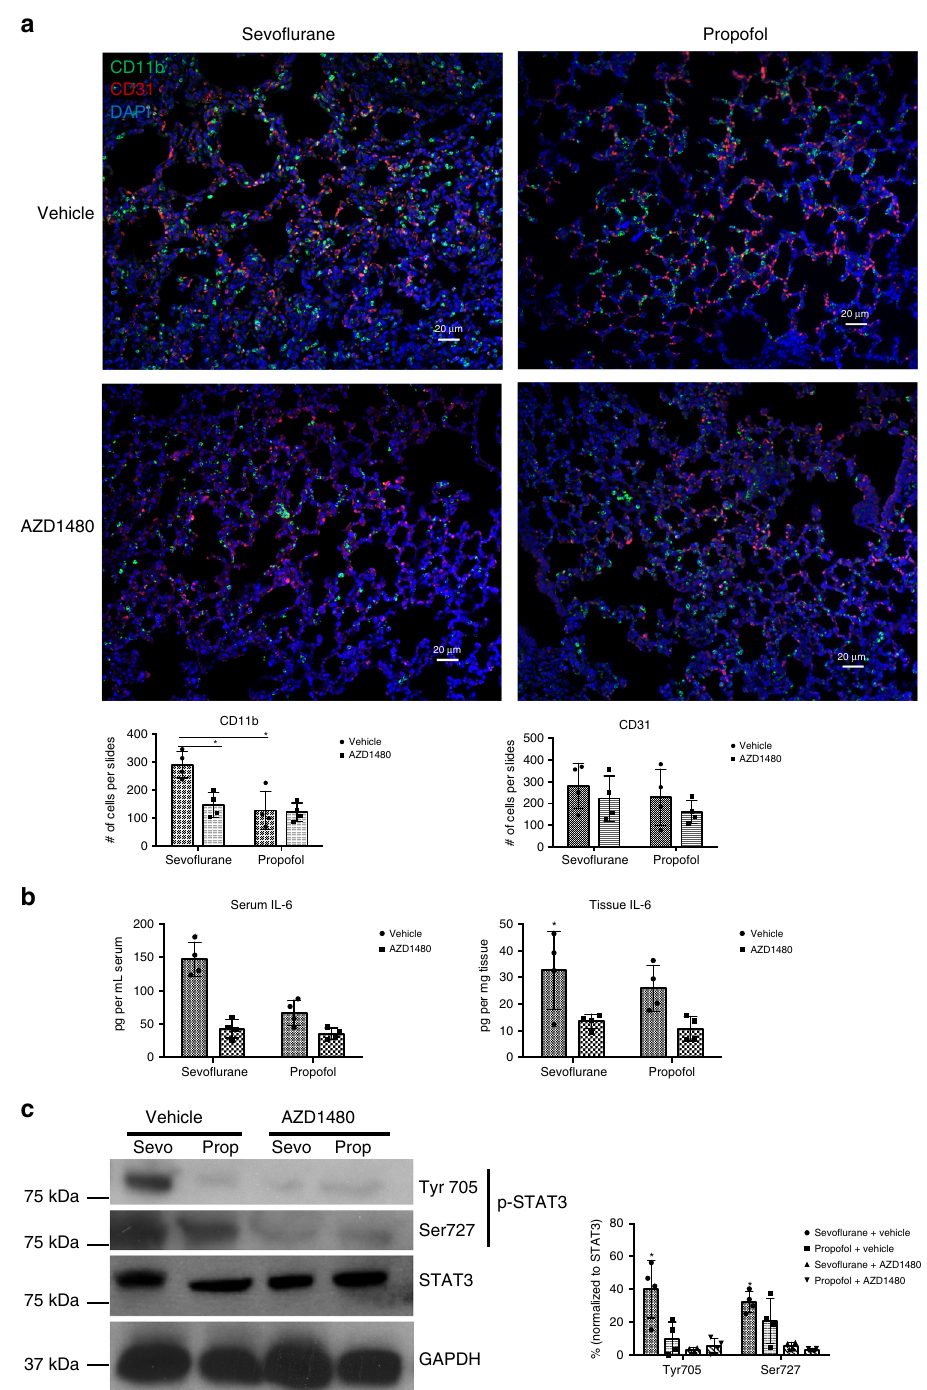
Fig. 4 AZD1480 treatment reduced the in fi ltration of CD11b + myeloid cells associated with sevo fl urane in the lung. a Sevo fl urane increased CD11b + cells in the lung one day after surgery compared to propofol by immuno fl uorescence imaging. Treatment with AZD1480 signi fi cantly reduced in fi ltrated CD11b + cells (green) induced by sevo fl urane in the lungs ( n = 4 mice in each group; sevo fl urane vs propofol, p = 0.007; sevo fl urane vehicle vs AZD1480, p = 0.032; two-way ANOVA + Dunnett ’ s post hoc tests, Scale bar = 20 μ m). No signi fi cant change was observed with CD31 positive cells (red). One day surgery, lungs of the mice were sectioned and stained with anti-CD11b, anti-CD31, and DAPI. b One day after surgery, AZD1480 treatment dramatically reduced serum and lung tissue level of IL-6 ( n = 4, p = 0.001 and 0.02 respectively, two-way ANOVA + Dunnett ’ s post hoc tests) by ELISA assays. c Western blot analysis of STAT3 phosphorylation showed that AZD1480 treatment signi fi cantly reduced p-Tyr705 (sevo fl urane vs propofol p = 0.03, sevo fl urane vs AZD1480 p = 0.001, two-way ANOVA + Dunnett ’ s post hoc tests) and p-Ser727 (sevo fl urane vs AZD1480 p = 0.001, n = 4, two-way ANOVA + Dunnett ’ s post hoc tests) one day after surgery with sevo fl urane. Data presented as the mean ± S.D. Source data are provided as a Source Data fi